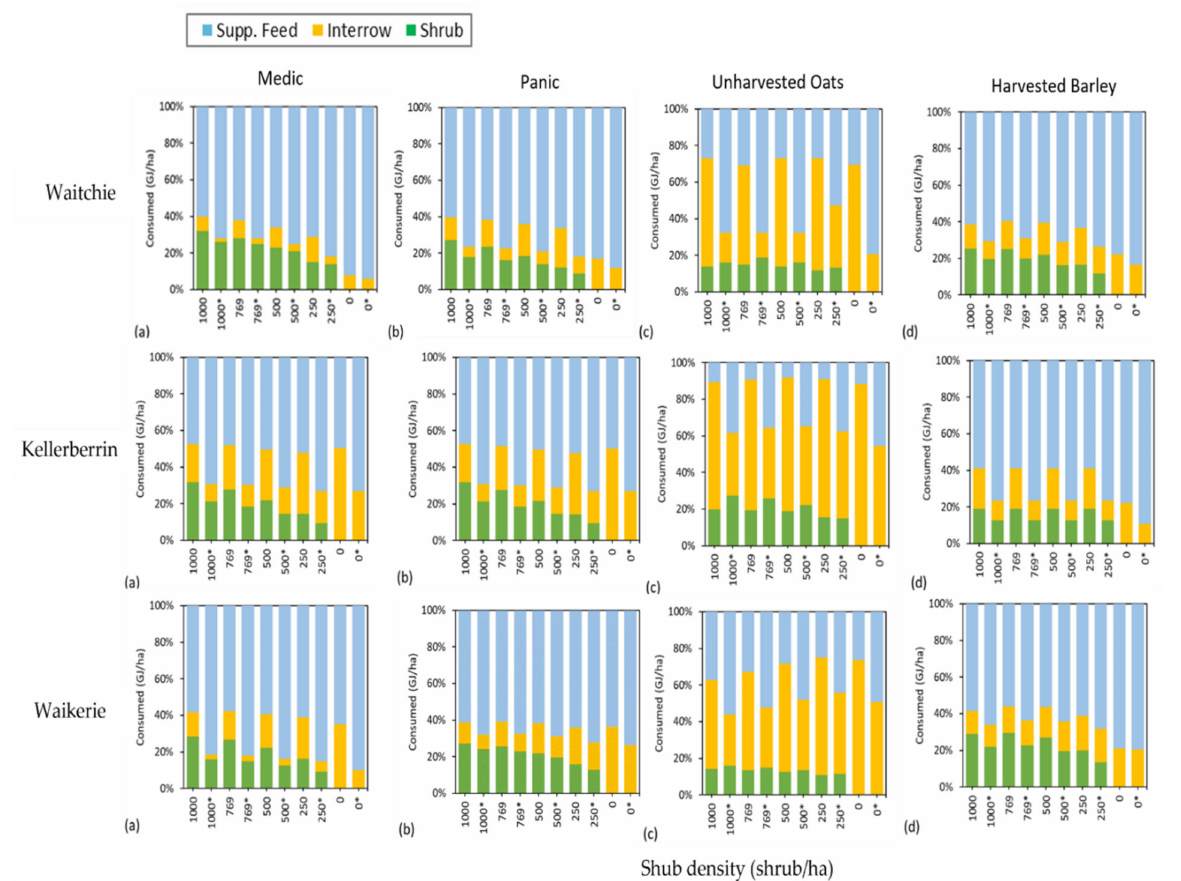
Figure 9. Average annual, proportional diet composition based on total energy (GJ/ha) for shrub (green columns), interrow (yellow columns) and supplementary feed (blue columns), for different shrub densities (shrubs/hectare) indicated on the x-axis at the three study sites (Waitchie, Kellerberrin, Waikerie) based on shrub systems with an interrow of ( a ) medic, ( b ) panic, ( c ) unharvested oats and ( d ) harvested barley. Columns with asterisk (*) indicate the average of the years during low rainfall-lowest 20% of the simulation